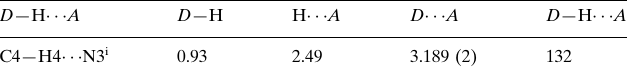
Hydrogen-bond geometry (A˚ , (cid:2)